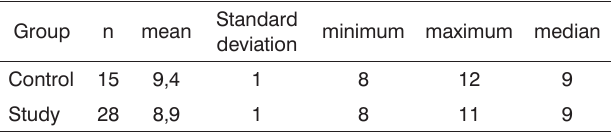
Table 2. Summary values of the group ages.